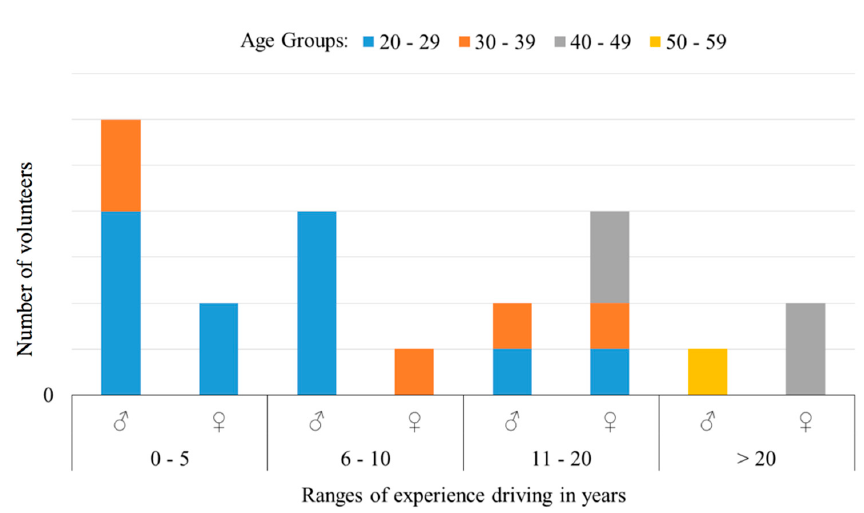
Figure 4. Number of people vs. driving experience, classified by age group and gender.